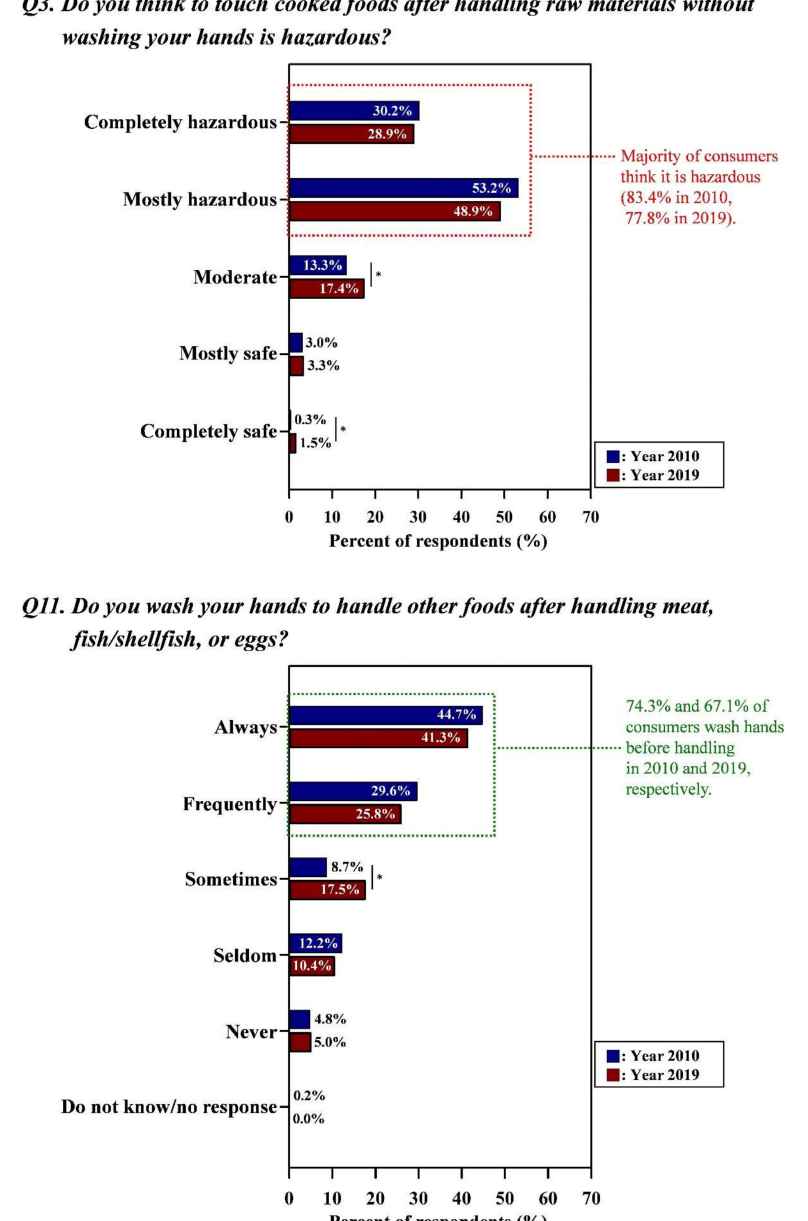
Figure 4. Proper behaviors of consumers in accordance with their perceptions regarding the washing hands. Asterisk (*) indicated between graphs means the significant di ff erences of responses (the Kruskal–Wallis test; p < 0.05) in each answer option from Year 2010 and Year 2019. Green letters indicated the proper risk perceptions (i.e., the correct response in line with conventional food safety guidelines) and behaviors of consumers. All data regarding the percentage of the combined answer options (e.g., Always + Frequently) are provided in Table